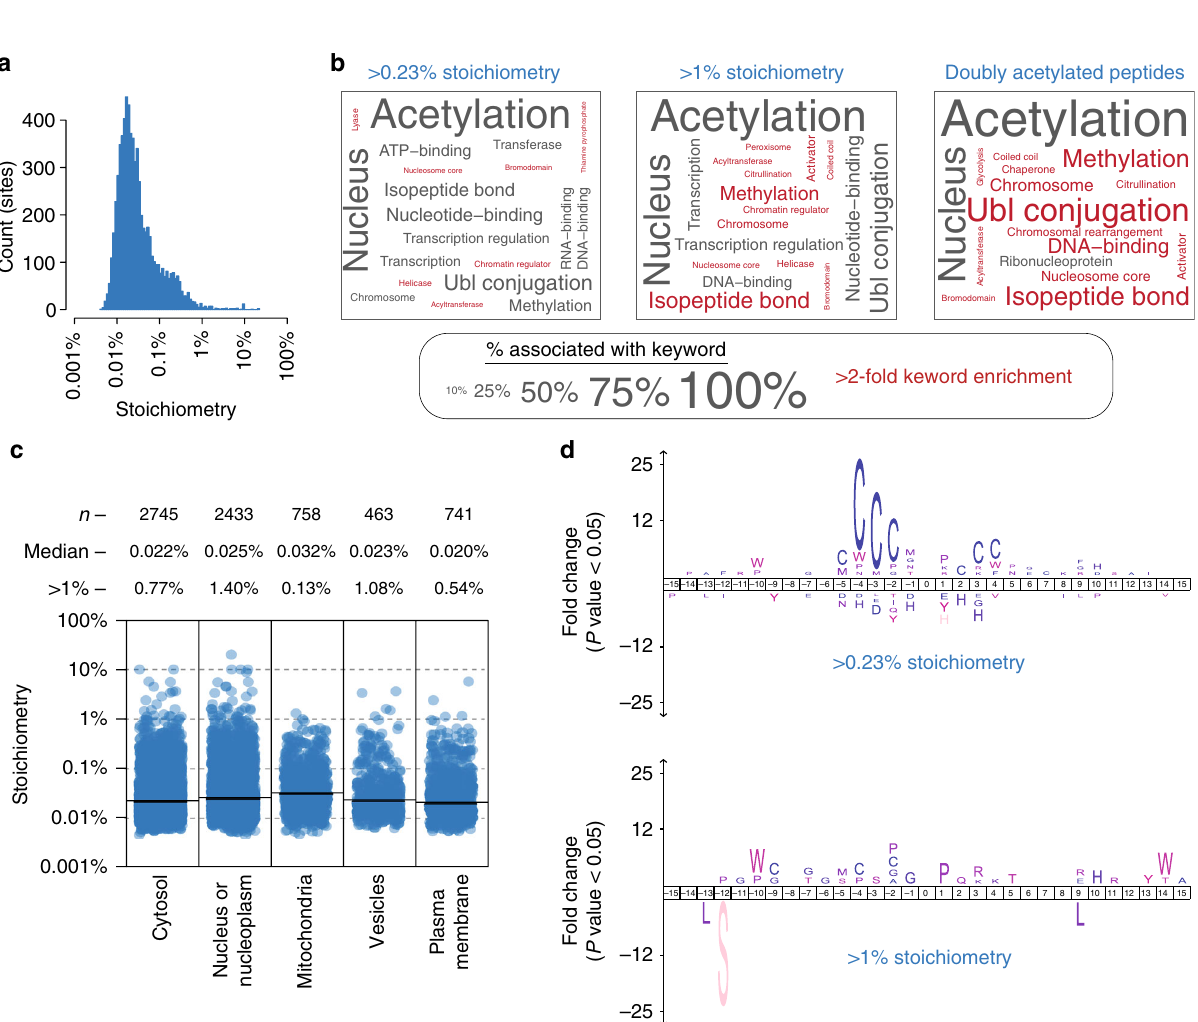
Fig. 3 Properties of high stoichiometry acetylation. a The distribution of acetylation site stoichiometry for the 6829 sites measured in this study. b UniProt keyword enrichment for the indicated classes of high stoichiometry acetylation sites (>0.23% and >0.1%) and for doubly acetylated peptides. The size of the text is related to the fraction of sites associated with the keyword, and keywords that were more than two-fold enriched are colored red. c Subcellular compartment analysis based on the Human Protein Atlas 14 . Category scatterplots show the distributions of acetylation site stoichiometry in each subcellular compartment. The number ( n ) of sites analyzed, median stoichiometry (median), and percentage of sites with >1% stoichiometry (>1%) is shown. d Amino acid sequence logos of the indicated classes of acetylation sites using IceLogo 15 . Source data are provided as a Source Data fi